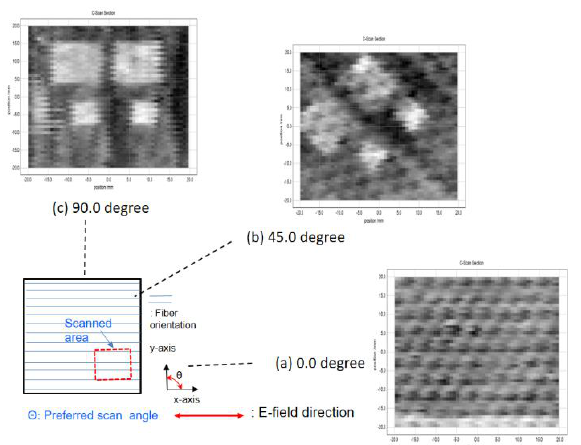
Figure 9. Terahertz scan images of carbon-skin honeycomb sandwiches composite panels with boned and brass foils (12.5 × 12.5 mm and 6.3 × 6.3 mm) at the bottom under TDS reflection mode.